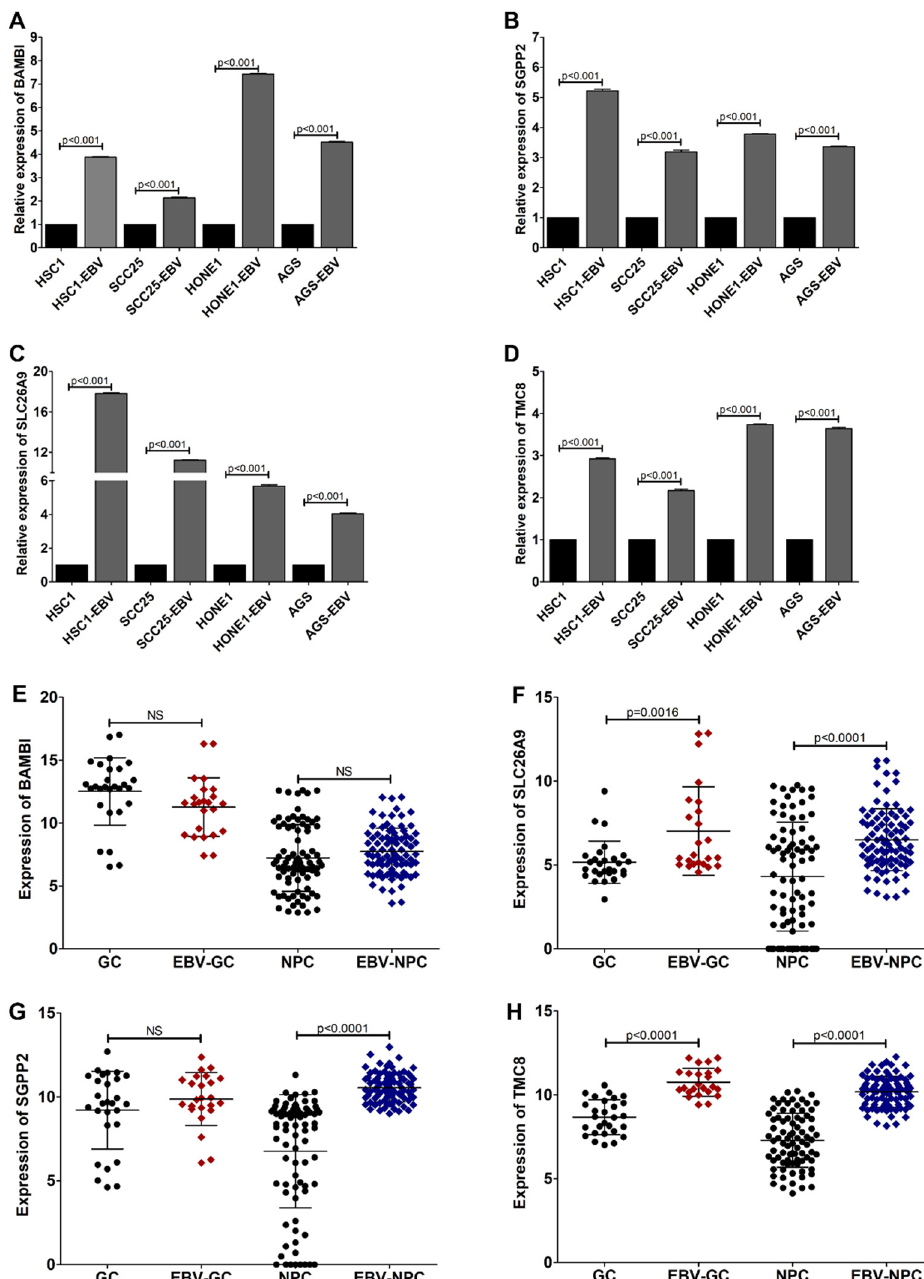
Figure 4. SLC26A9 and TMC8 could be used as a gene signature for EBV-associated epithelial cancers. The expression of BAMBI ( A ), SLC26A9 ( B ), SGPP2 ( C ), and TMC8 ( D ) was examined in both EBV-infected and EBV-uninfected cells by qRT-PCR. The expression of BAMBI ( E ), SLC26A9 ( F ), SGPP2 ( G ), and TMC8 ( H ) was also examined in tumor tissues of EBV-associated epithelial cancers. 3.3. TMC8 Is a Potential Gene Signature for EBV-Associated Malignancies To identify our gene signature for EBV-associated malignancies, both lymphoma and epithelial malignancies, we further examined the expression of SCL26A9 and TMC8 in various types of cancer cell lines, including lymphoma and epithelial cancers, using the RNA sequencing dataset (DepMap 21Q4 Public) from the Cancer Cell Line Encyclopedia (CCLE) database. In the present study, 282 cell lines were included; among these, 20 cell lines were infected with EBV. As shown in Figure 5, the expression level of TMC8, but not SLC26A9, was significantly upregulated in EBV-positive cell lines compared with EBV ‐